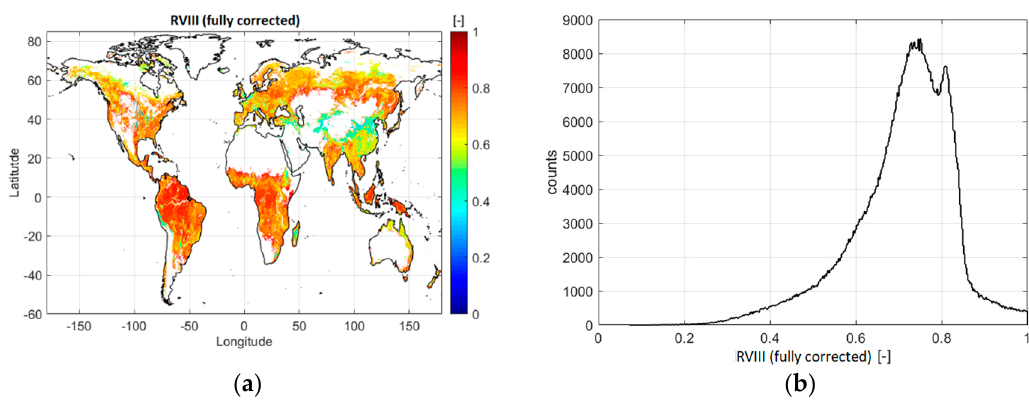
Figure 9. Result of the averaged (April–July 2015) RVIII [-] calculated with (9): ( a ) global map; ( b ) histogram of values ranging only between zero and one.